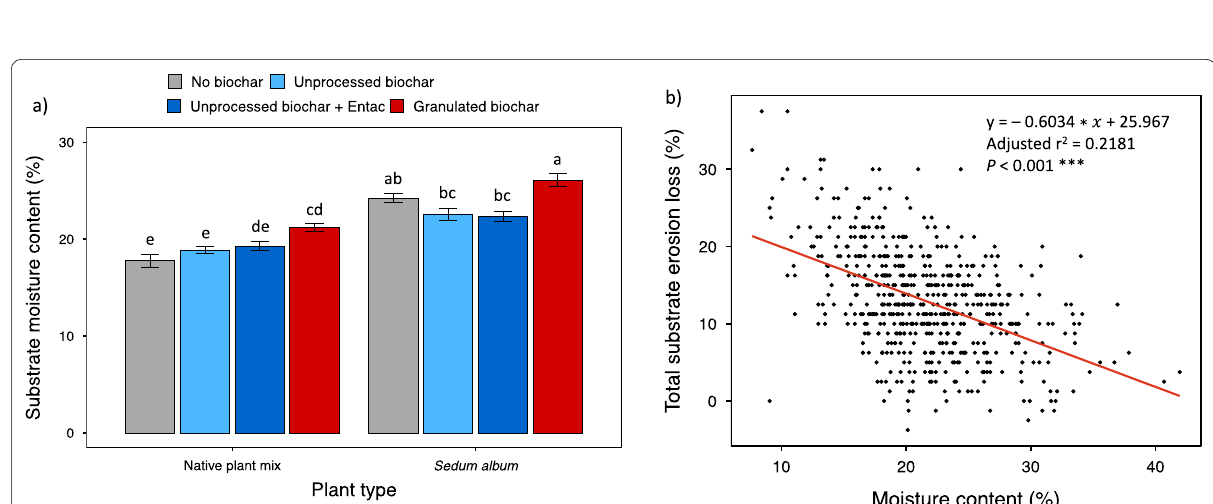
Fig. 3 Substrate moisture content by treatment ( a ), and pooled relationship between substrate moisture content and total substrate erosion loss ( b ) on green roof modules. Bars plot mean substrate moisture content 1 standard error (n 7 replicates per treatment). Bars with different ± = lowercase letters within each figure differ significantly at P < 0.05 according to Tukey’s HSD test following two-way ANOVA. The fitted linear regression model pools all measurements (n 576). Asterisks indicate significance of model: *** P < =